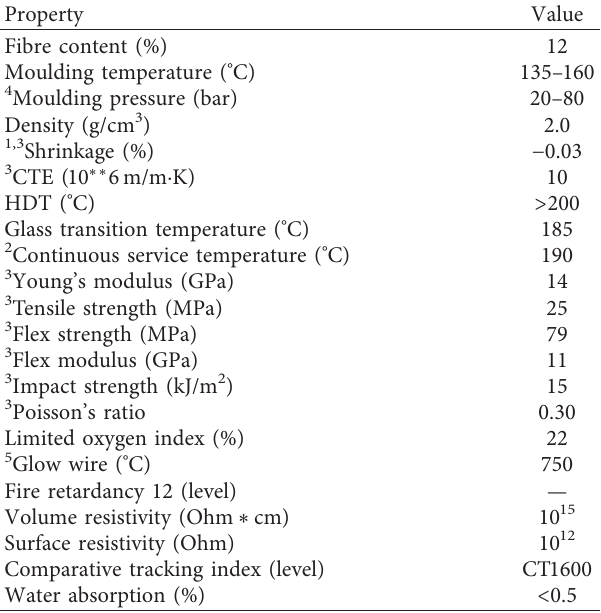
Table 1: Properties of Menzolit BMC 3100 (adapted from [13]).